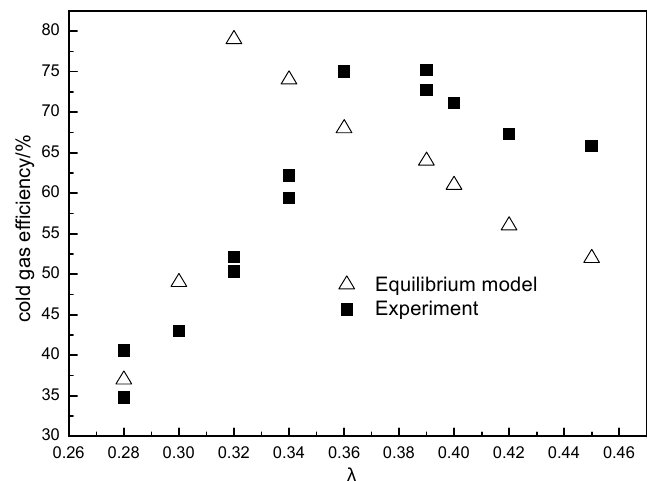
Figure 13. Cold gas efficiency of theoretical vs. experimental results.